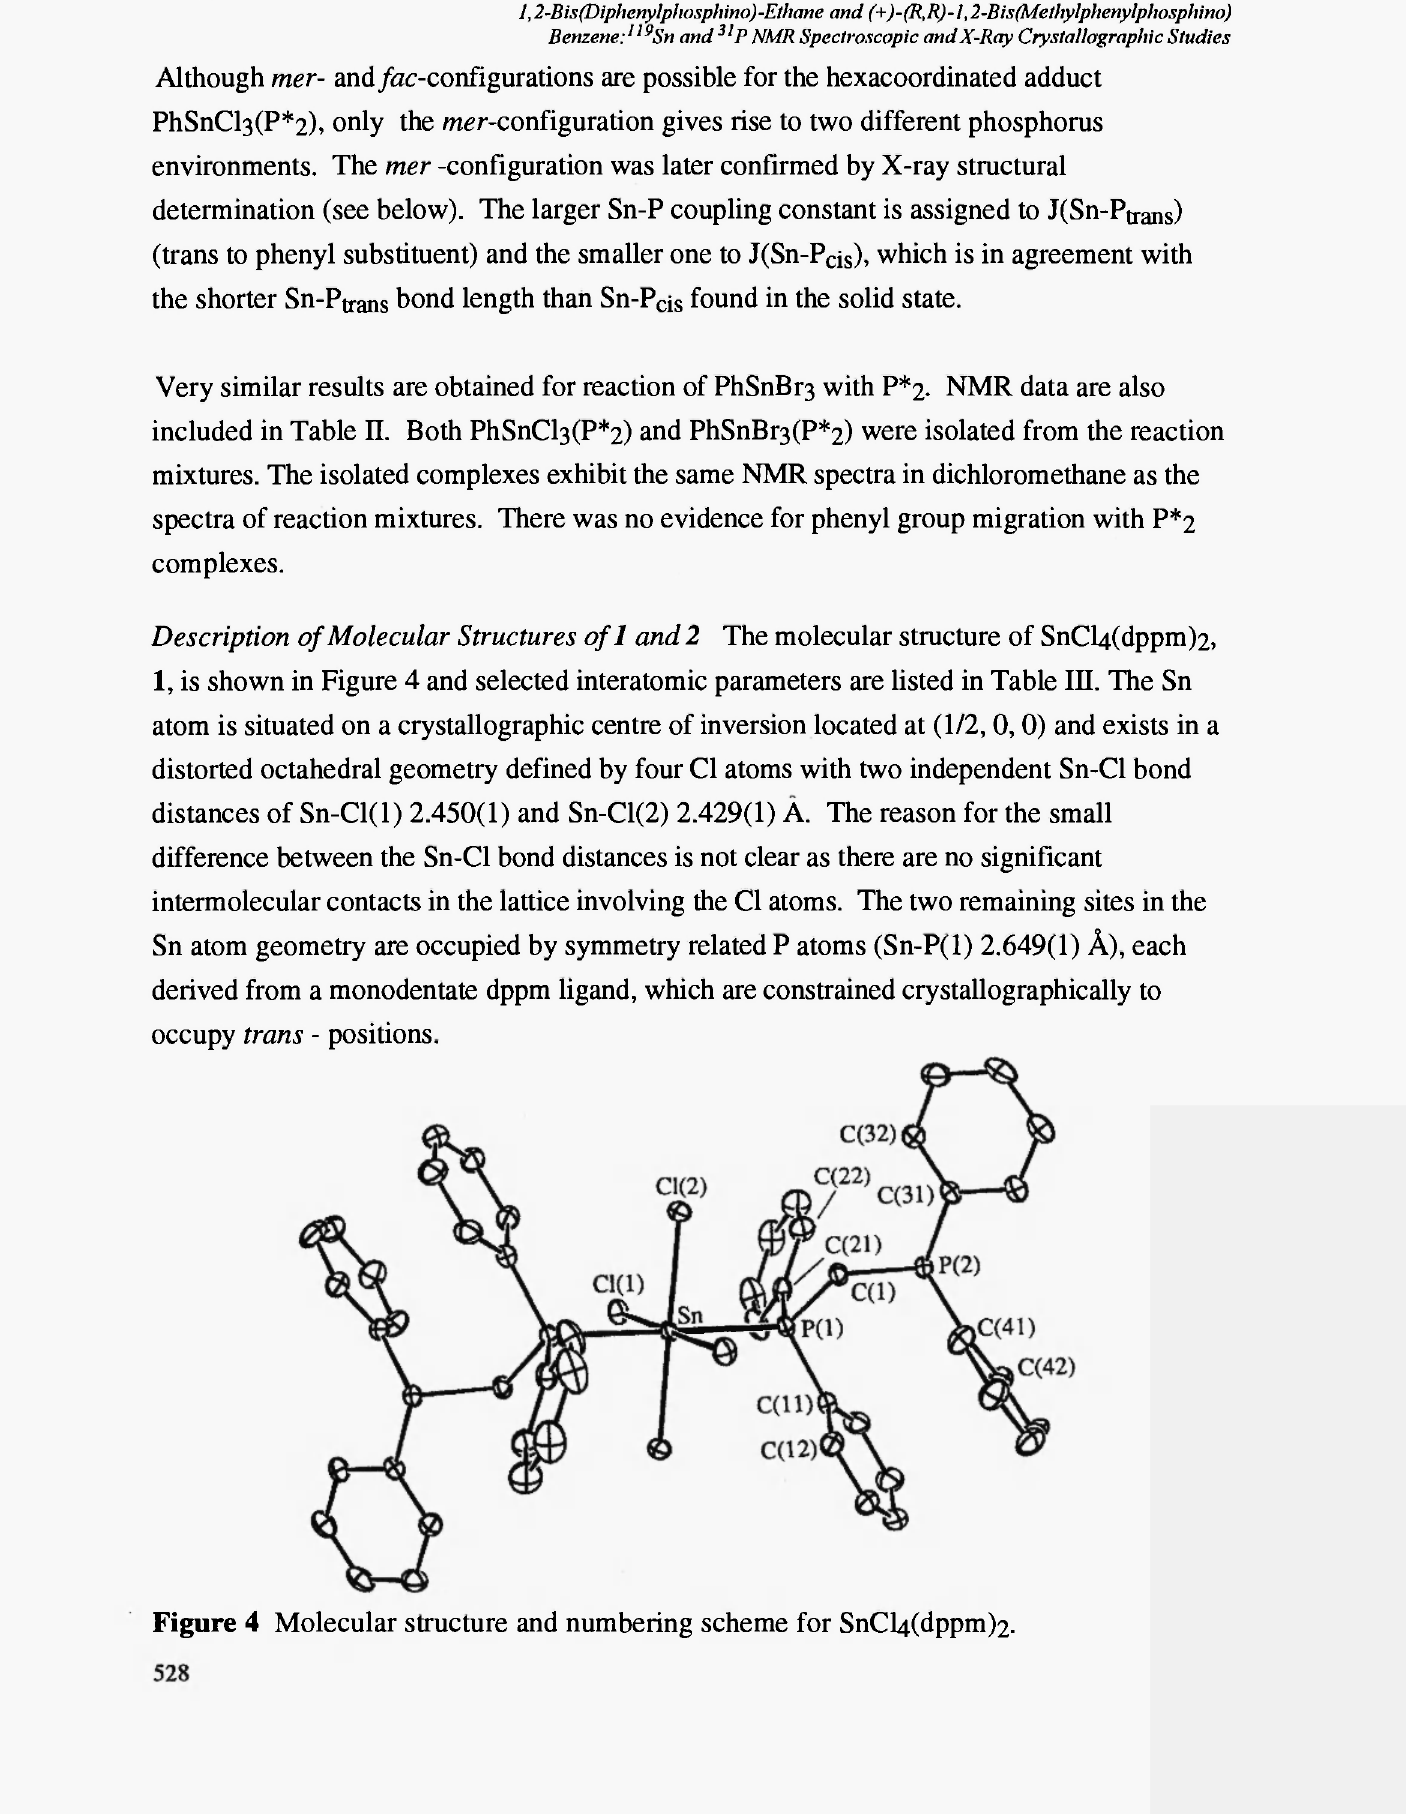
Figure 4 Molecular structure and numbering scheme for